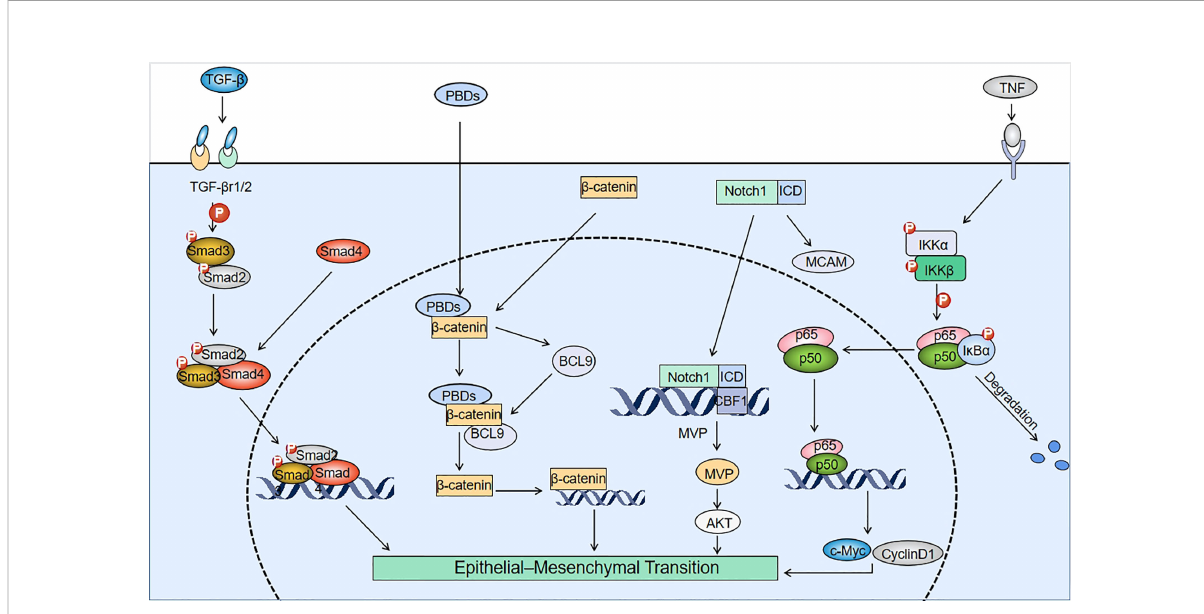
FIGURE 2 Mechanisms involved in PBD-induced EMT. TGF- b interacts with TGF- b receptors (TGF- b r1/2) to induce phosphorylation of Smad2/3, which binds to Smad4 to form a Smad2/3/4 complex. After platinum-based drugs (PBDs) enter tumor cells, they bind to the N-terminus of b -catenin and upregulate BCL9. BCL9 can form a complex with b -catenin to create positive feedback that promotes b -catenin expression, and induces the epithelial-mesenchymal transition (EMT). The pathways for Notch1 to induce EMT include: promoting melanoma cell adhesion molecule (MCAM) expression and binding of the Notch1 internal domain (ICD) to the CBF1 site of the major vault protein ( MVP ) gene to upregulate MVP. The binding of tumor necrosis factor (TNF) to membrane surface receptors drives IkB kinase (IKK) to phosphorylate IkB. Degradation of IkB forms the p65/p50 dimeric complex that binds to EMT-related